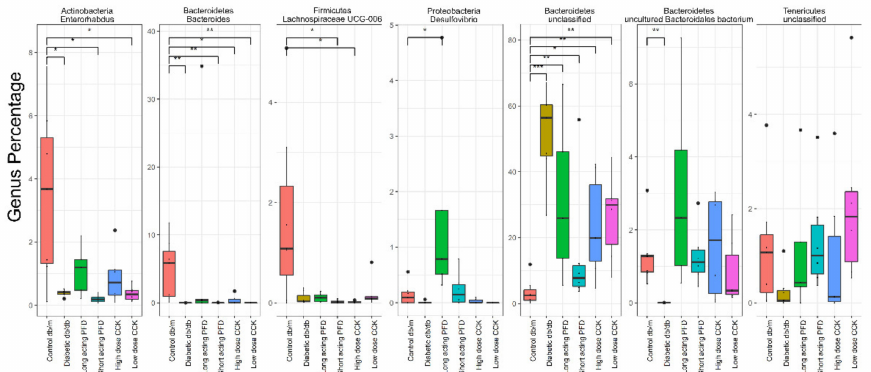
Figure 4. Genus level comparison between control db / m, db / db, and four treatment groups. The genus was selected using DESeq2 with FDR less than 0.05. Significance levels between two groups is indicated by stars (* 0.01 to 0.05, ** 0.001 to 0.01, *** 0.0001 to 0.001) and no comparison / stars mean no statistical significance was found between